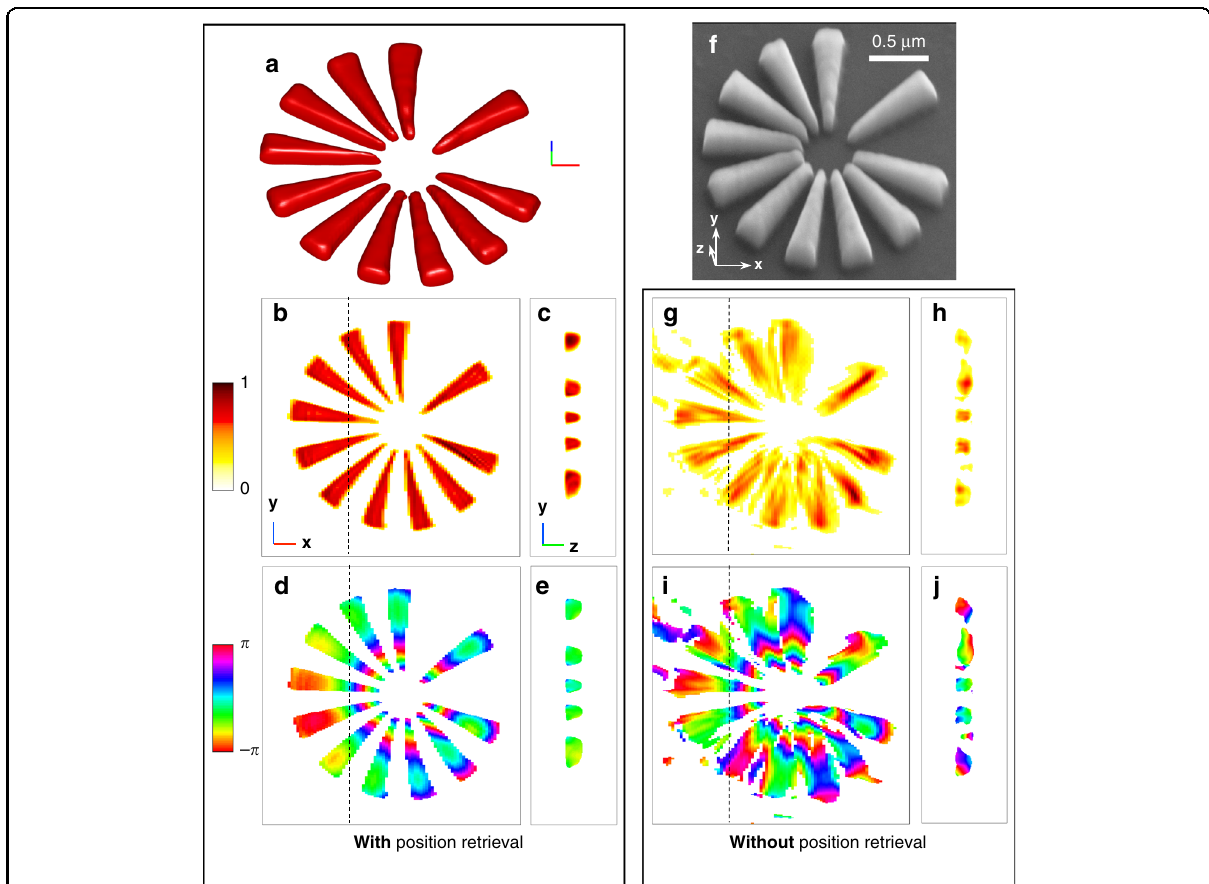
Fig. 2 3D Reconstruction of the crystalline Si-star. a 3D volume rendering (iso-surface) of the amplitude of the retrieved modulus image. b , c 2D cross-sections of the 3D amplitude map: b is taken at the half-height of the sample structure, while c is taken along the dotted line shown in b . The amplitude linear color scale is shown in arbitrary units. d , e 2D cross-sections of the 3D phase map, taken in the same planes as the ones shown in b and c , respectively. The phase color scale is shown in radians. f SEM picture of the same Si-star sample, to be compared to the iso-volume shown